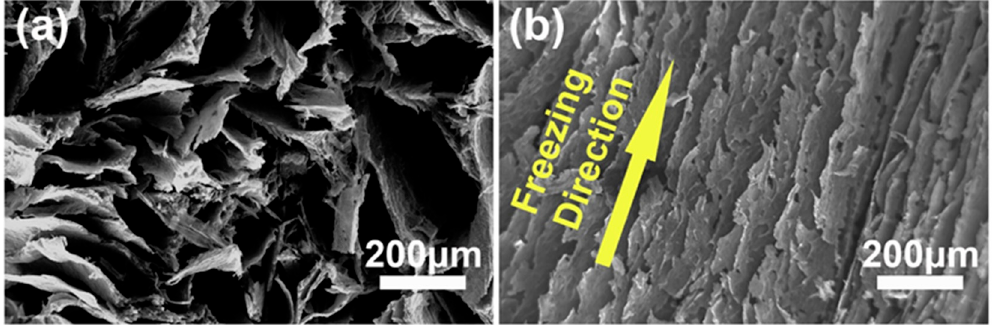
Figure 3. ( a ) SEM image of the cross-sectional area; ( b ) SEM image of the longitudinal